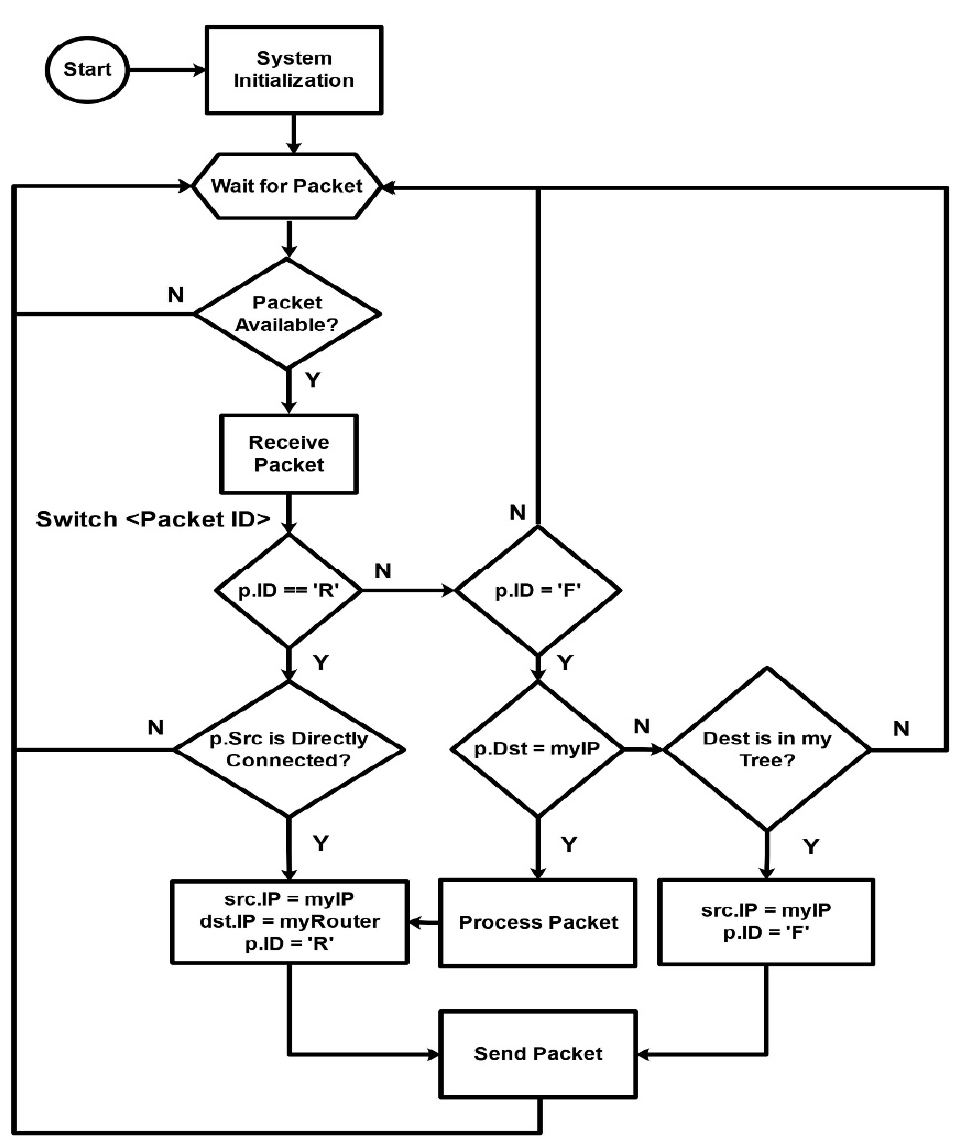
Figure 6. Flow diagram of sensor node